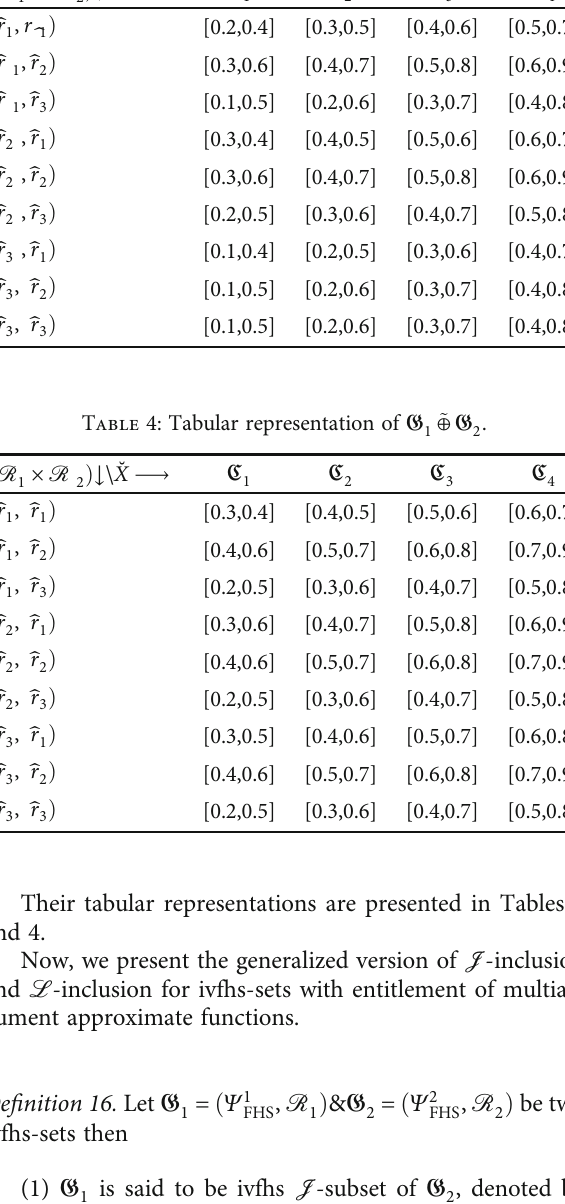
Table 3: Tabular representation of G